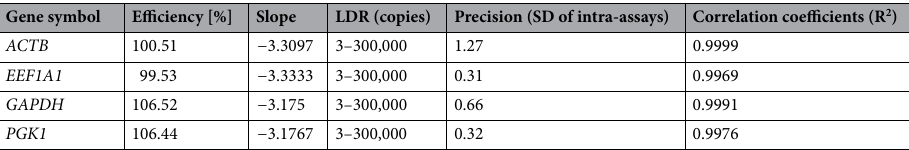
Table 1. Summary of the performance of primers employed in this